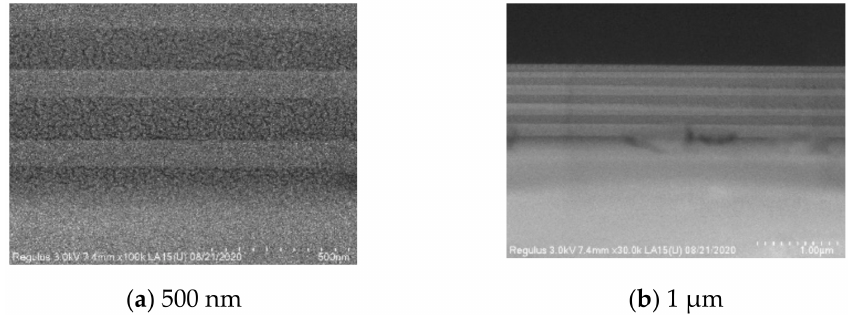
Figure 8. Nb 2 O 5 /SiO 2 multilayer thin-film SEM data for 80 sccm